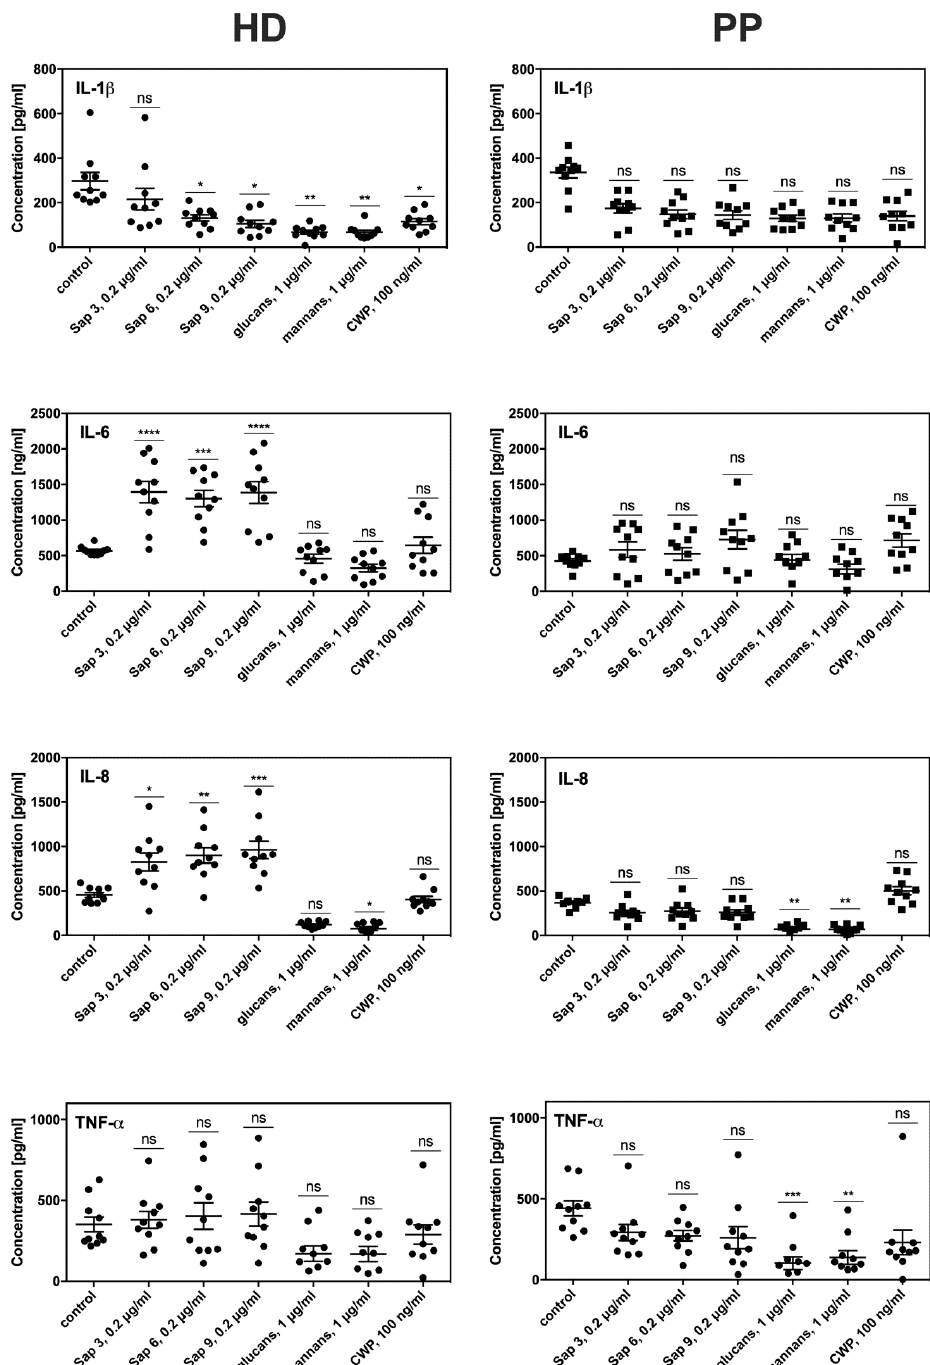
Figure 6. Cytokine production by fibroblasts from ( HD ) healthy donors and from ( PP ) periodontitis patients (right panels). The secretion of specific cytokines was identified by ELISA in the growth medium of fibroblasts that contacted with different fungal virulence factors for 6 h. The experiments were performed in duplicate in three independent sets. Data from a representative set were presented. Asterisks